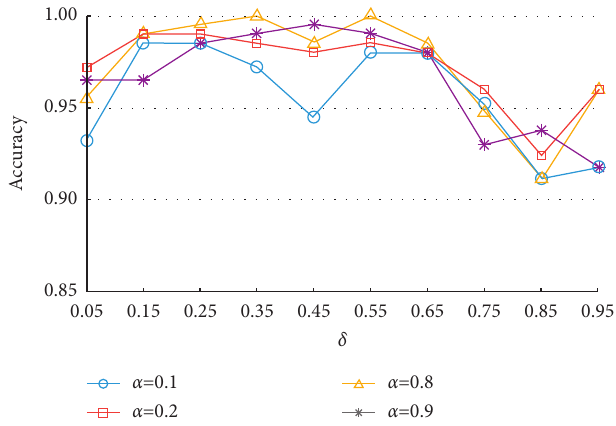
Figure 5: Average accuracies of ECHDNRS on Arabidopsis -Oxygen dataset.